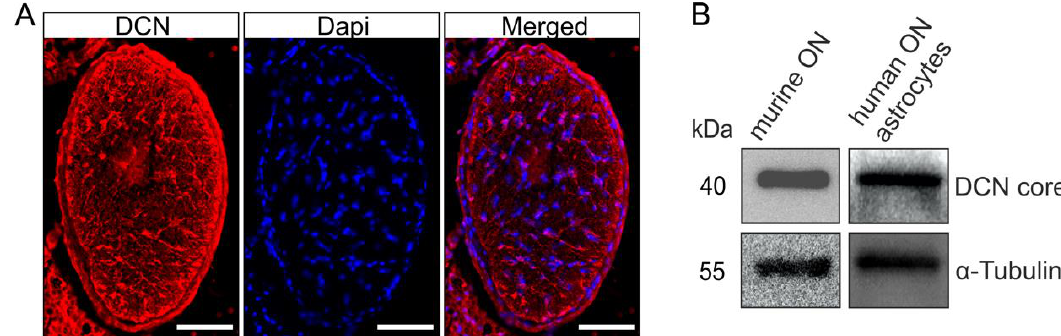
Figure 2. DCN is present in the human ONH and murine ON. A positive signal for DCN was observed in cross sections through murine ONs ( A , scale bar 50 µm). Presence of DCN in the murine ON was confirmed via Western blot; Western blot analysis also showed that human ONH astrocytes produce DCN ( B ).